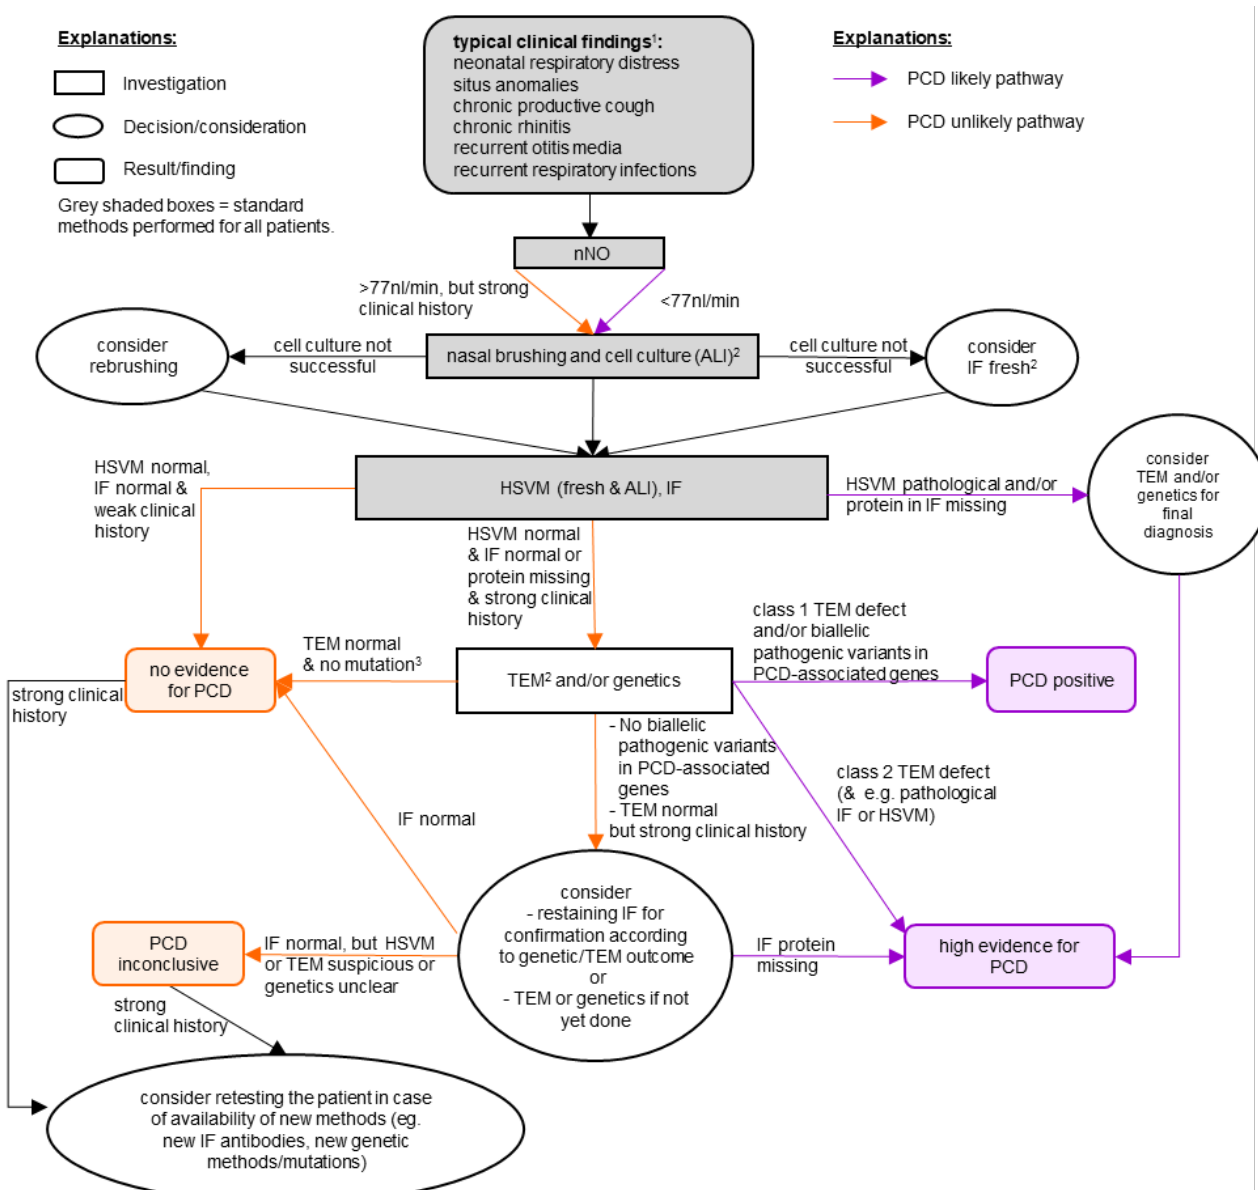
Figure 1. Diagnostic workflow of our comprehensive PCD-UNIBE diagnostic center. “PCD positive” and “high evidence for PCD” are considered as a diagnosis of PCD. For patients with a high clinical suspicion, we usually perform all available methods. 1 As a clinical screening, the PICADAR-Score [22] may be useful. 2 Further investigations (HSVM, IF, and TEM) are preferably conducted by analyzing the material of the ALI cell cultures. A re-brushing is considered if cell culture was not successful. When re-brushing was not possible, fresh material was used. 3 We recommend further investigations (e.g., RNA-analysis or array-CGH) if other results suggest PCD. Abbreviations: ALI: air-liquid interface, HSVM: high- speed-videomicroscopy, IF: immunofluorescence staining, nNO: nasal nitric oxide, PCD: primary ciliary dyskinesia, TEM: transmission electron